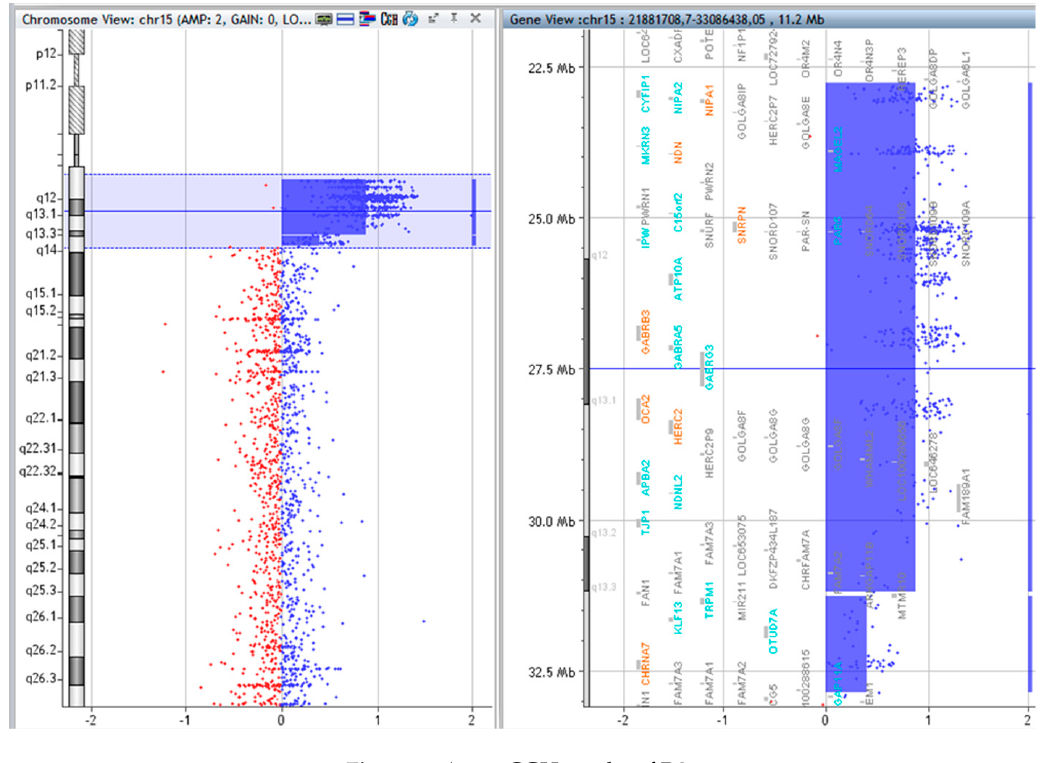
Figure 3. Array CGH results of P.2.